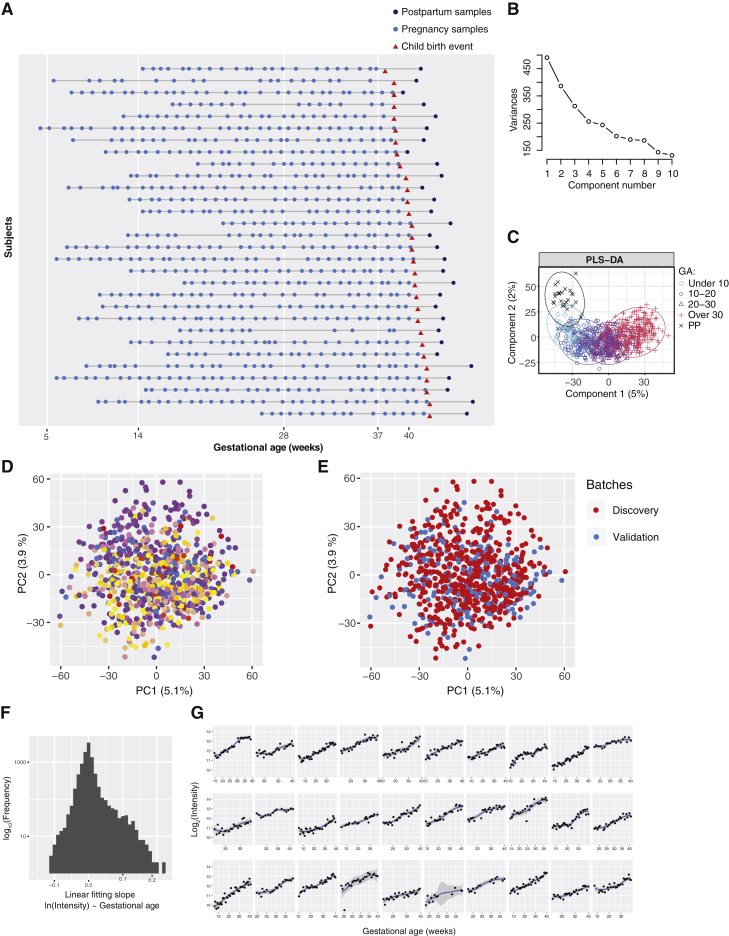
Untargeted Metabolomics for Longitudinal Pregnancy Samples, Related to Figure 1(A) High-density longitudinal sampling of pregnancies.(B) The Scree plot of the principal component analysis.(C) The PLS-DA result according to the categories of gestational age. GA: gestational age; PP: postpartum.(D and E) Principal component analysis based on all 9,651 features shows that the samples do not separate according to the 30 subjects (D) samples from individual subjects are represented by different colors or experimental batches of Discovery and Validation (Test Set 1) analyzed across two different years (E) samples of the discovery cohort are presented in red; samples of the validation cohort (Test Set 1) are presented in blue.(F) Histogram shows the distribution of slopes in the linear fitting model of the 9,651 features (intensities against the gestational ages).(G) For each of the 30 women, the intensities of an example metabolic feature are shown over the course of gestation, which reveals consistent increases in abundance according to gestational age among 30 subjects, despite individual differences.